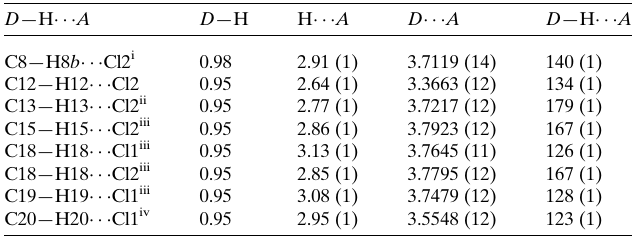
Table 1 Hydrogen-bond geometry (A˚ , (cid:4) ).